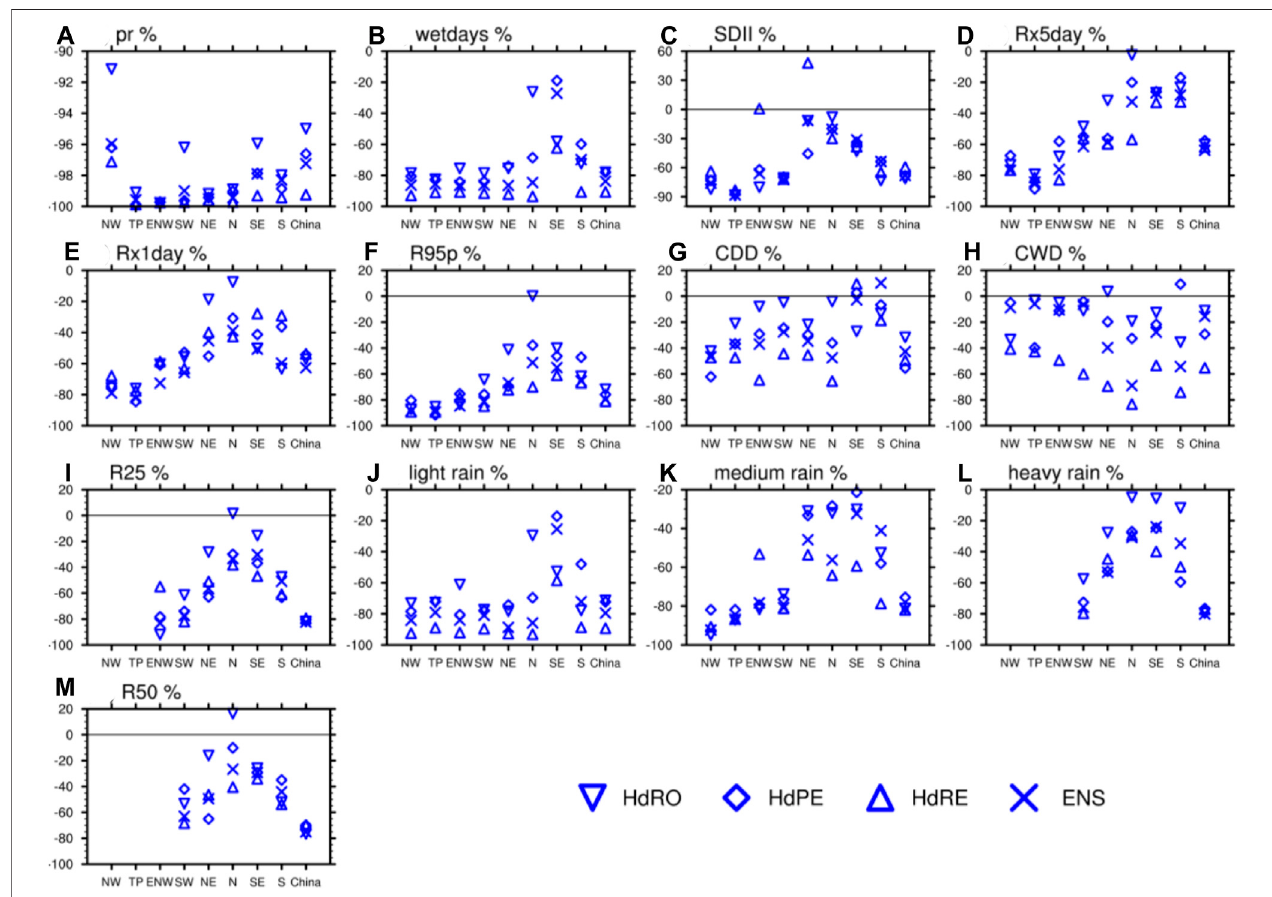
FIGURE 7 | The reduction ratios of the RMSE of mean precipitation (A – C) , extreme precipitation (D – F) , drought indexes (G,H) and precipitation days (I – M) by using bias correction methodology (CDF-t).